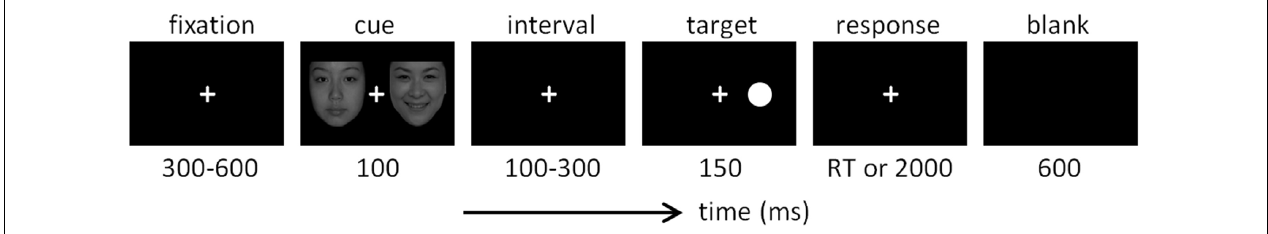
FIGURE 1 | Illustration of one experimental trial in this